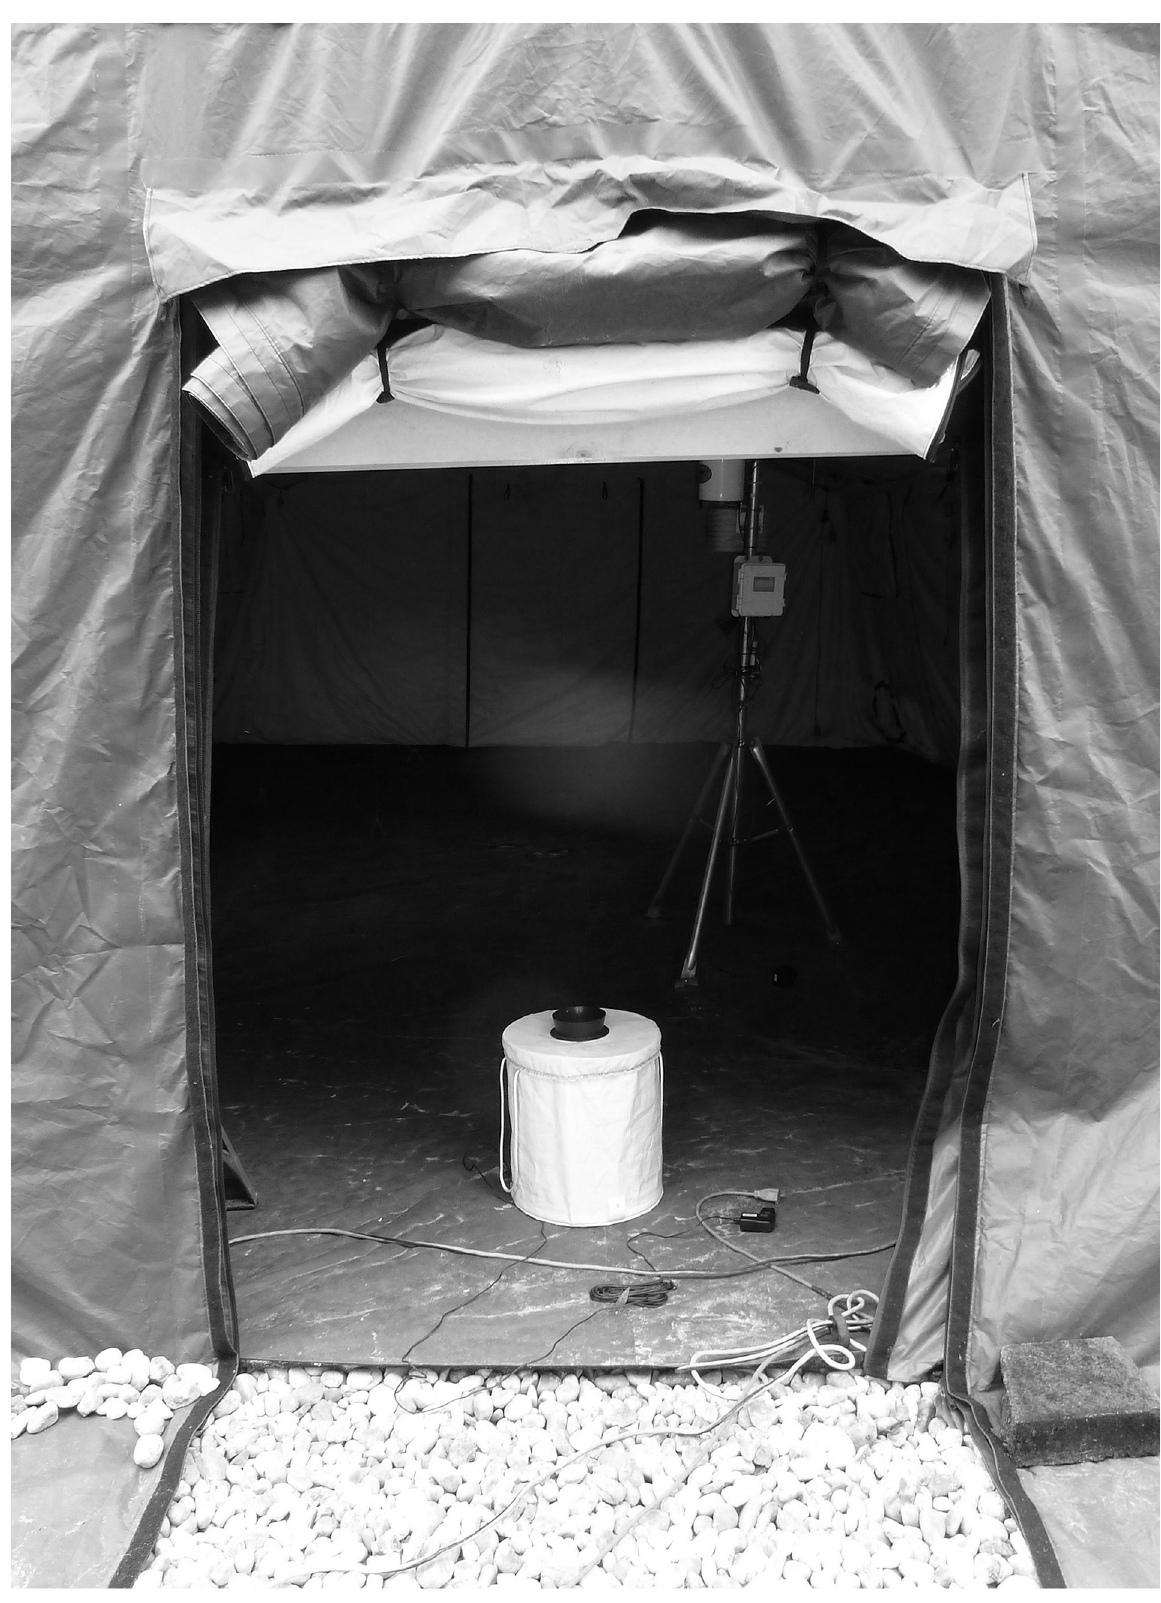
Fig 3. Semi-field set-up showing the tent inside the outdoor cage, BGS trap and FFS. doi:10.1371/journal.pone.0129878.g003 PLOS ONE | DOI:10.1371/journal.pone.0129878 June 26,